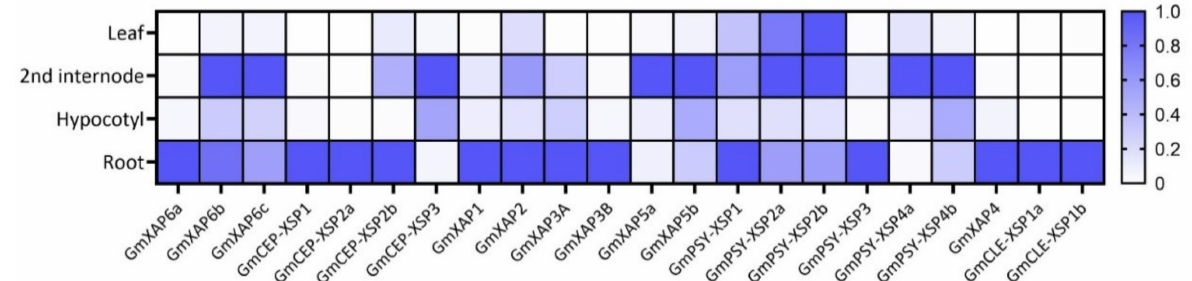
Figure 1. Relative expression levels of soybean xylem sap peptide precursor genes in different tissue regions. The relative expression levels of the peptide precursor genes are based on the tissues with maximal expression. Values of 1 represent the maximal expression level of the gene. The soybean gene ELF1b was used as a reference gene for normalization.